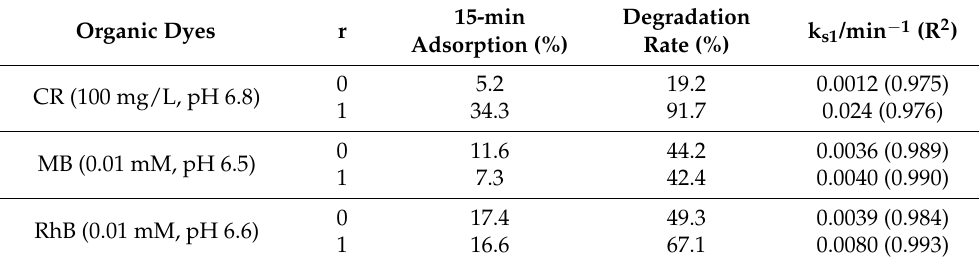
Table 2. CWPO of organic dyes over F-Fe 3 O 4 -r